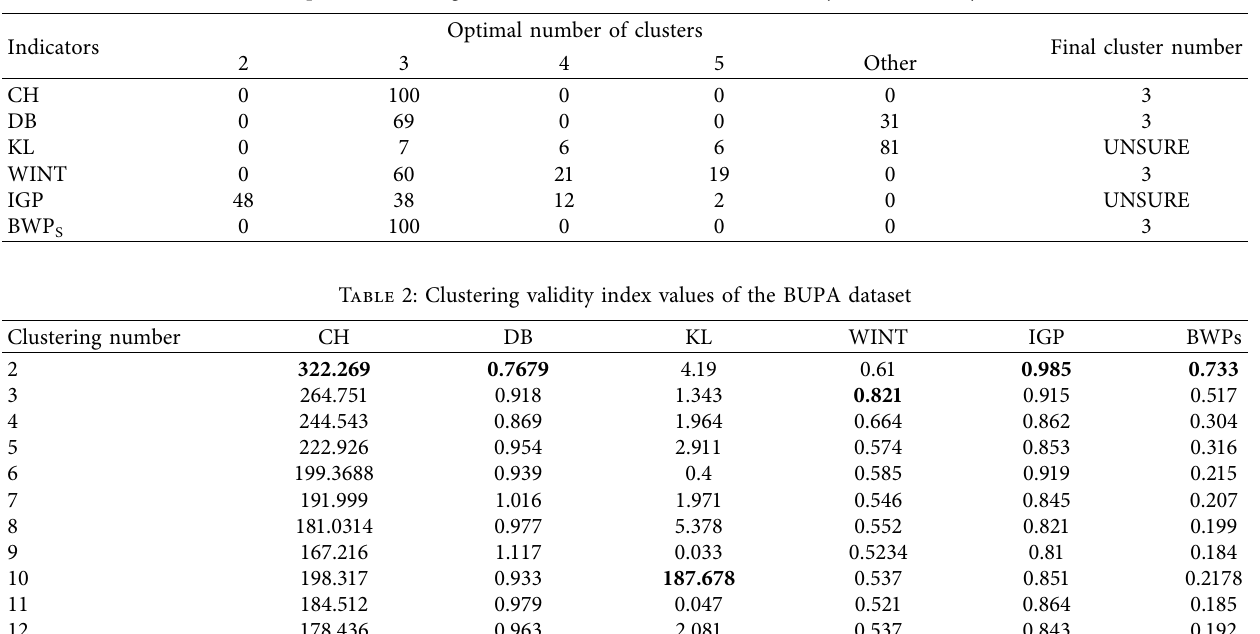
Table 1: The optimal clustering number of the Y 3C dataset estimated by several validity indicators.